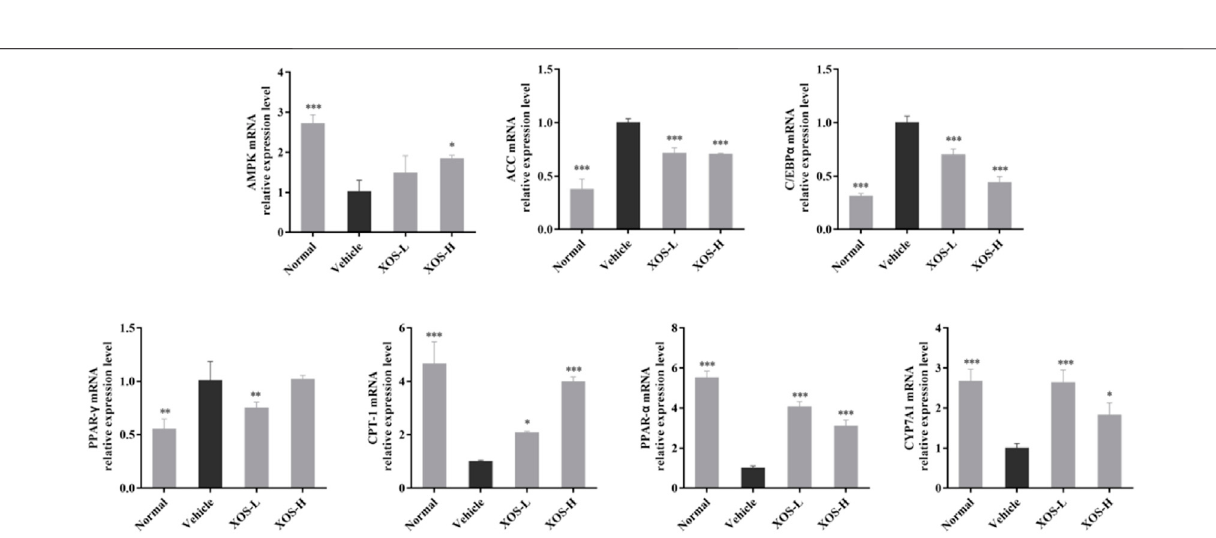
Frontiers in Pharmacology |